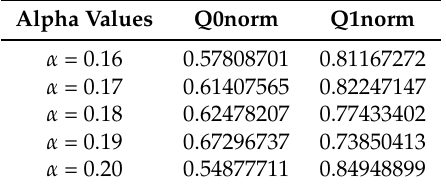
Figure 3. Choice of α for a partition in K = 5 clusters when D 1 is the geographical distances between ) versus α (in black solid line) and municipalities. ( Top ) proportion of explained pseudo-inertias Q 0 ( P α K ) versus α (in gold dashed line). ( Bottom ) normalized proportion of explained pseudo-inertias Q 1 ( P α K ( P α ) versus α (in black solid line) and Q ∗ ( P α ) versus α (in gold dashed line). Q ∗ K K 0 1 Table 1. Normalized proportion of explained